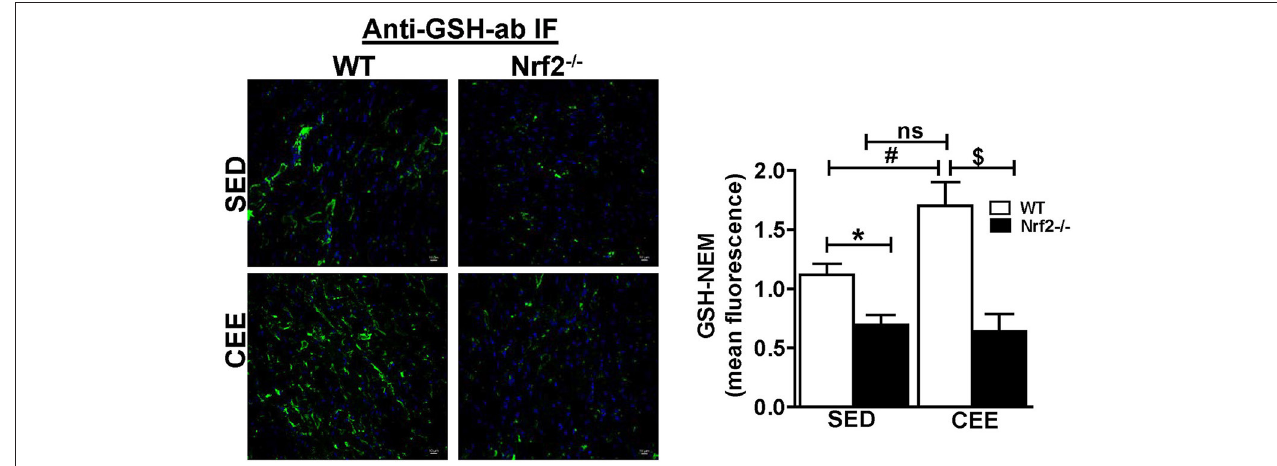
FIGURE 3 | Prolonged endurance exercise decreases GSH levels in aged Nrf2 deficient mice: WT and Nrf2 − / − mice heart cryosections were fixed and permeabilized for immunofluorescence staining for GSH-NEM. Permeabilized heart sections were incubated with NEM (10mM) followed by incubation with GSH-NEM antibodies and processed for imaging with 60X magnification. Captured images were quantified for fluorescence intensity and mean fluorescence intensity was represented as histogram ( n = 4/group). Experiments were analyzed using one way ANOVA followed by Tukey multiple comparison tests and differences between the means were considered statistically significant if P < 0.05 (* vs. WT-SED, # vs. Nrf2 − / − -SED, $ vs. WT CEE).